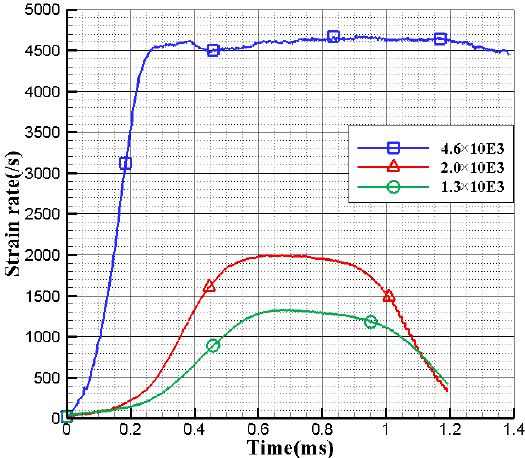
Figure 16. Mean stress rate curve at various strain rate.